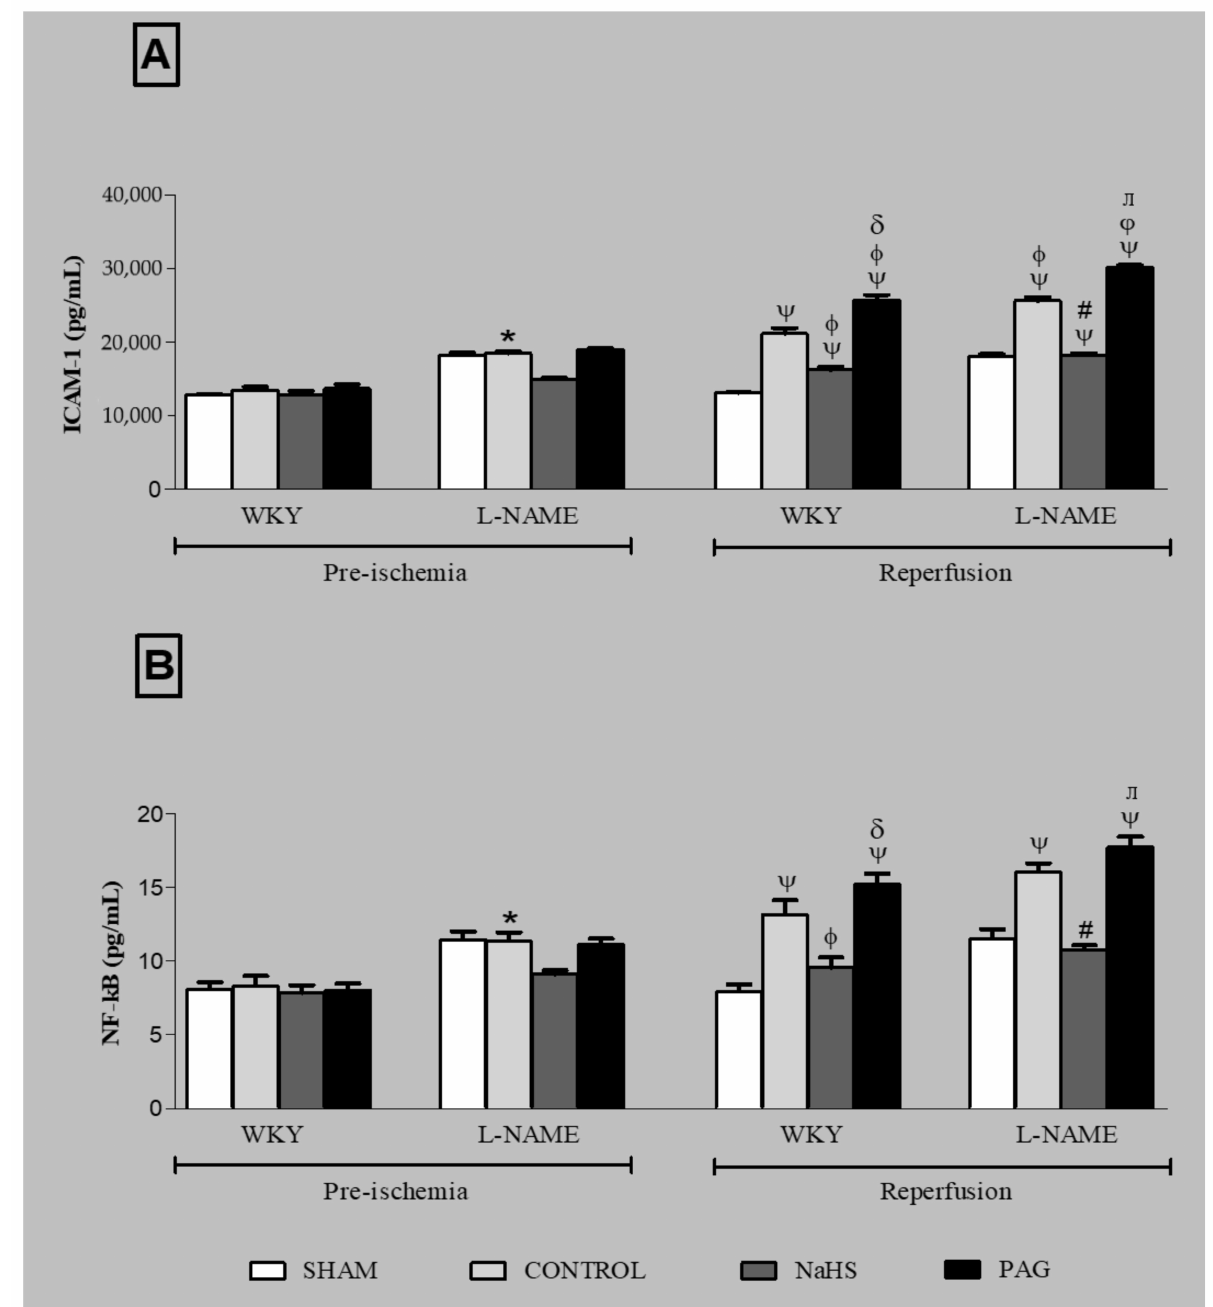
Figure 5. ICAM-1 concentration ( A ) and NF-kB concentration ( B ) in the kidney tissues of different experimental groups of WKY and L-NAME rats before and after ischemia ( n = 6). Data were analysed using one-way ANOVA followed by Bonferroni’s post hoc test. Ψ p < 0.05 vs. pre-ischemic phase of respective groups; * p < 0.05 vs. WKY-CONTROL at pre-ischemic phase; φ p < 0.05 vs. WKY-CONTROL at reperfusion phase; δ p < 0.05 vs. WKY+NaHS at reperfusion phase; # p < 0.05 vs. L-NAME-CONTROL at reperfusion phase; л p < 0.05 vs. L-NAME+NaHS at reperfusion phase. ICAM- 1 = intercellular adhesion molecule-1. NF-kB = nuclear factor-kappa B, PAG = dL-propargylglycine, WKY = Wistar Kyoto rats, L-NAME =